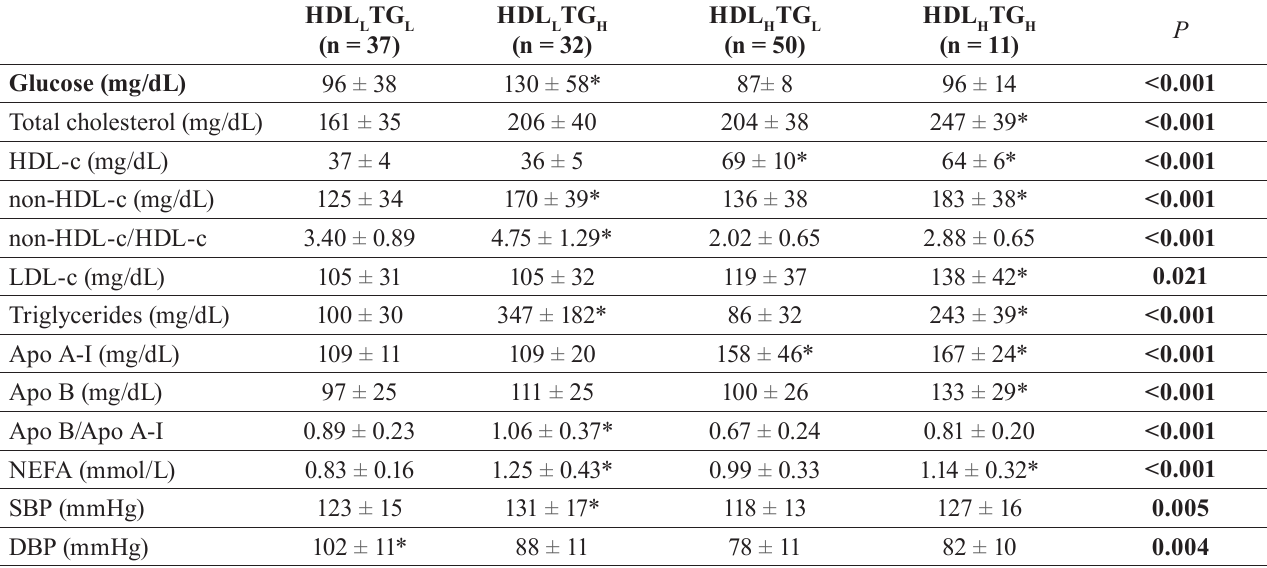
TABLE III - Biochemical profile and blood pressure